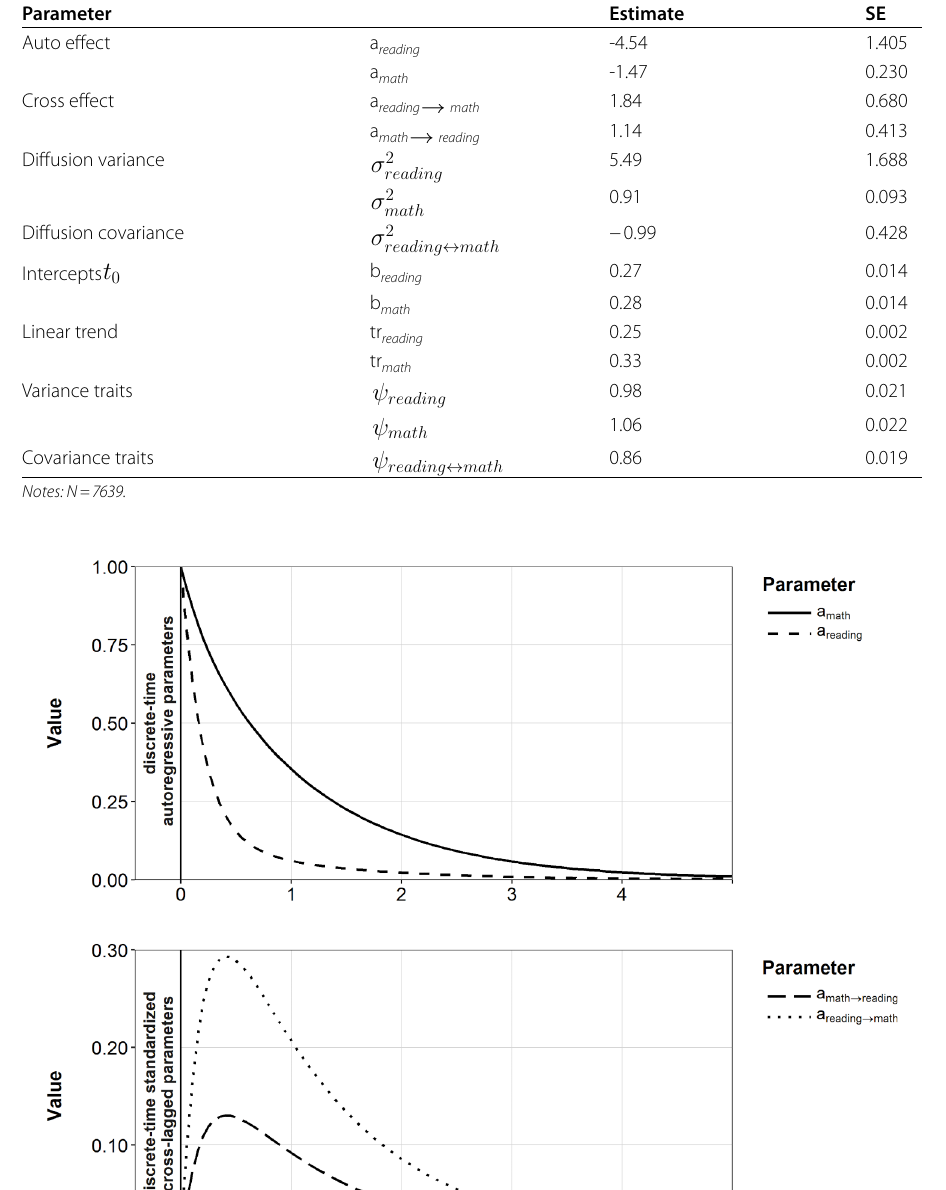
Table 4 – Continuous time model parameter estimates for math and reading